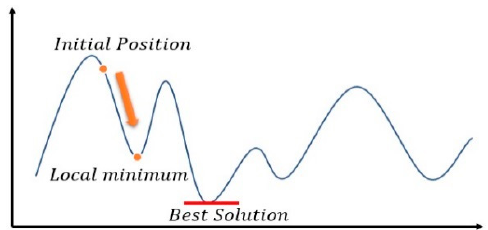
Figure 3. ICP Trapped in Locally Optimal Solution.